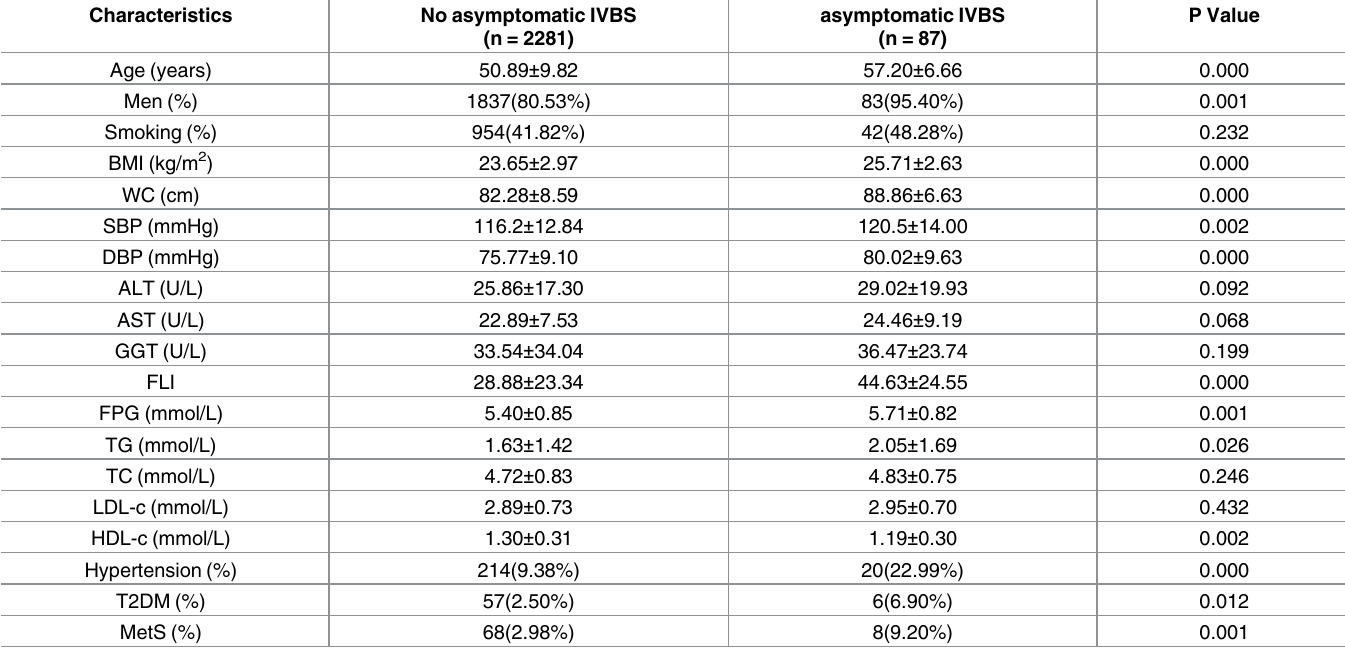
Table 1. Characteristics of participants with or without IVBS in cross-sectional